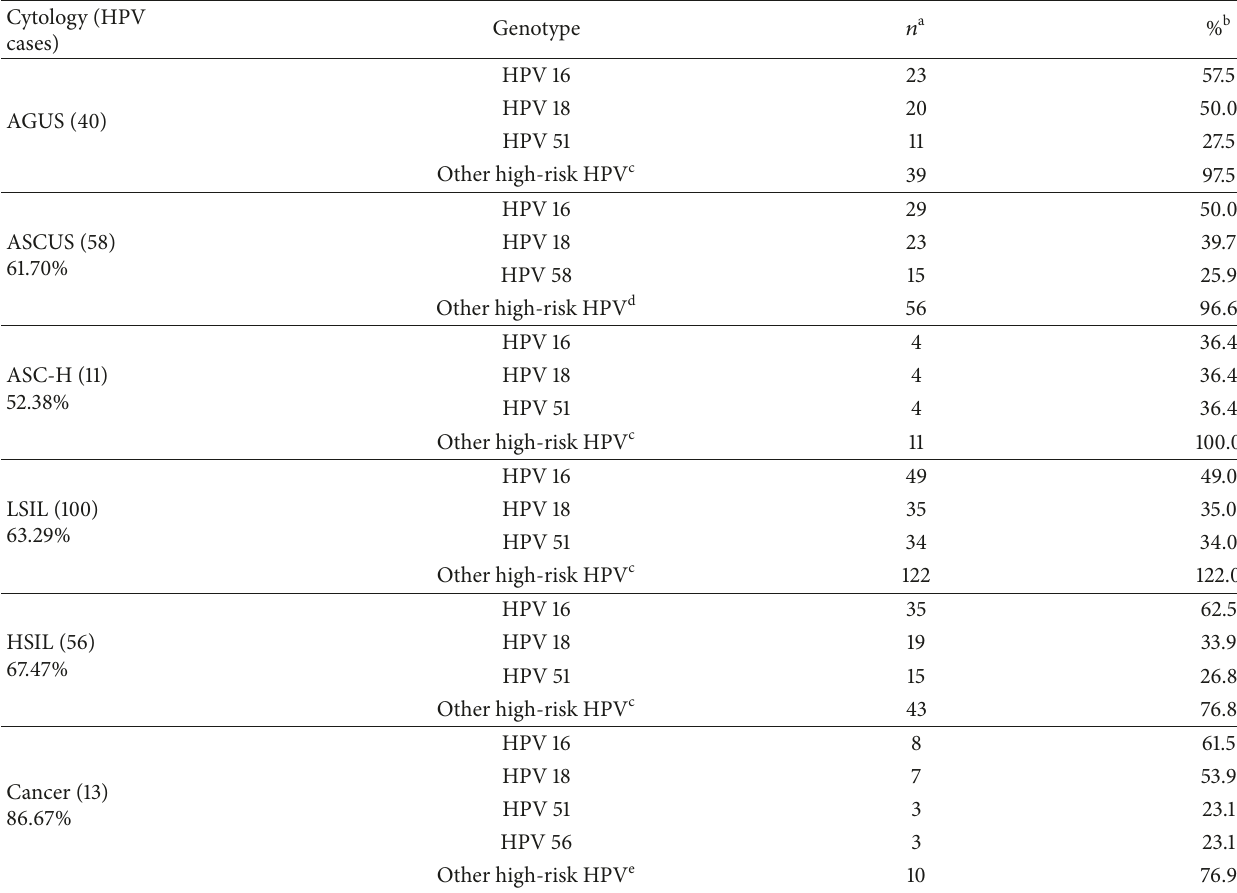
Table 3: Frequency of HPV genotypes in all cytological